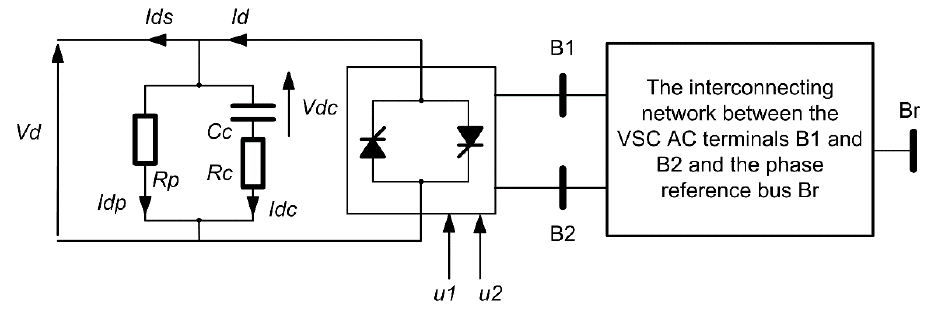
Figure 1. Generic voltage source converter (VSC) model, source [25].